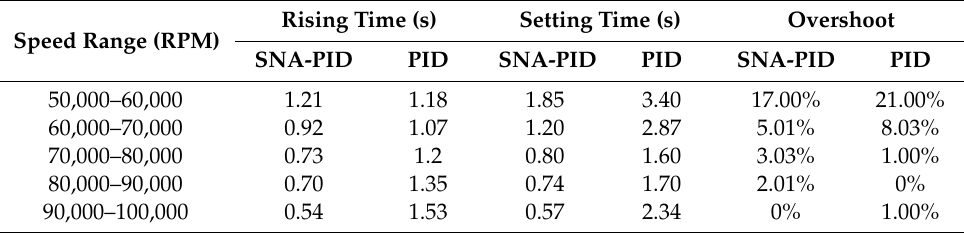
Table 6. Performance comparisons for Case